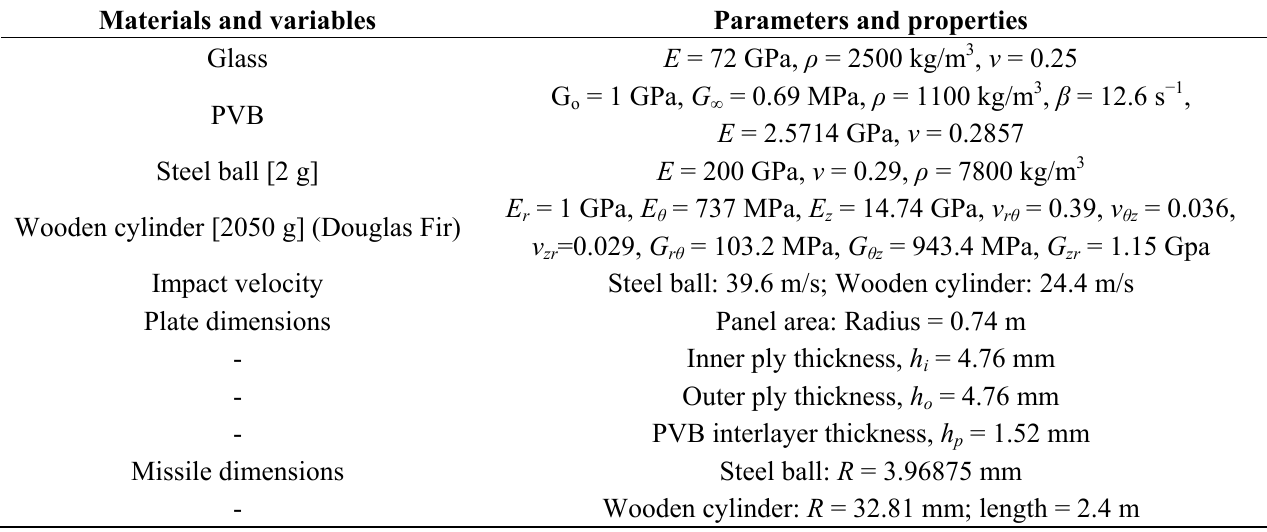
Table 1. Baseline data.